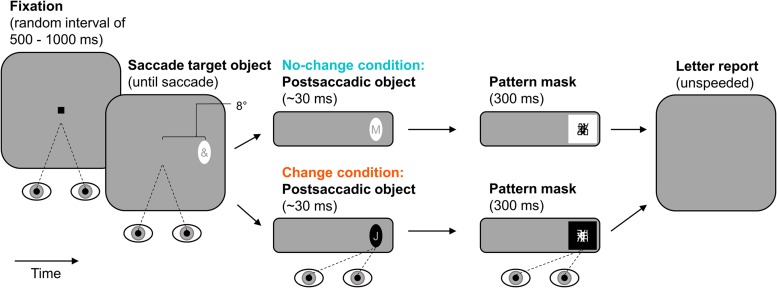
Paradigm of Experiment 2. Observers made a saccade to an elliptic object containing an irrelevant special character. The postsaccadic object was either of the same (no-change condition) or of the opposite contrast-polarity (change condition). It contained a letter and was visible for approximately 30 ms after the saccade (pattern-masked). Observers reported letter identity.